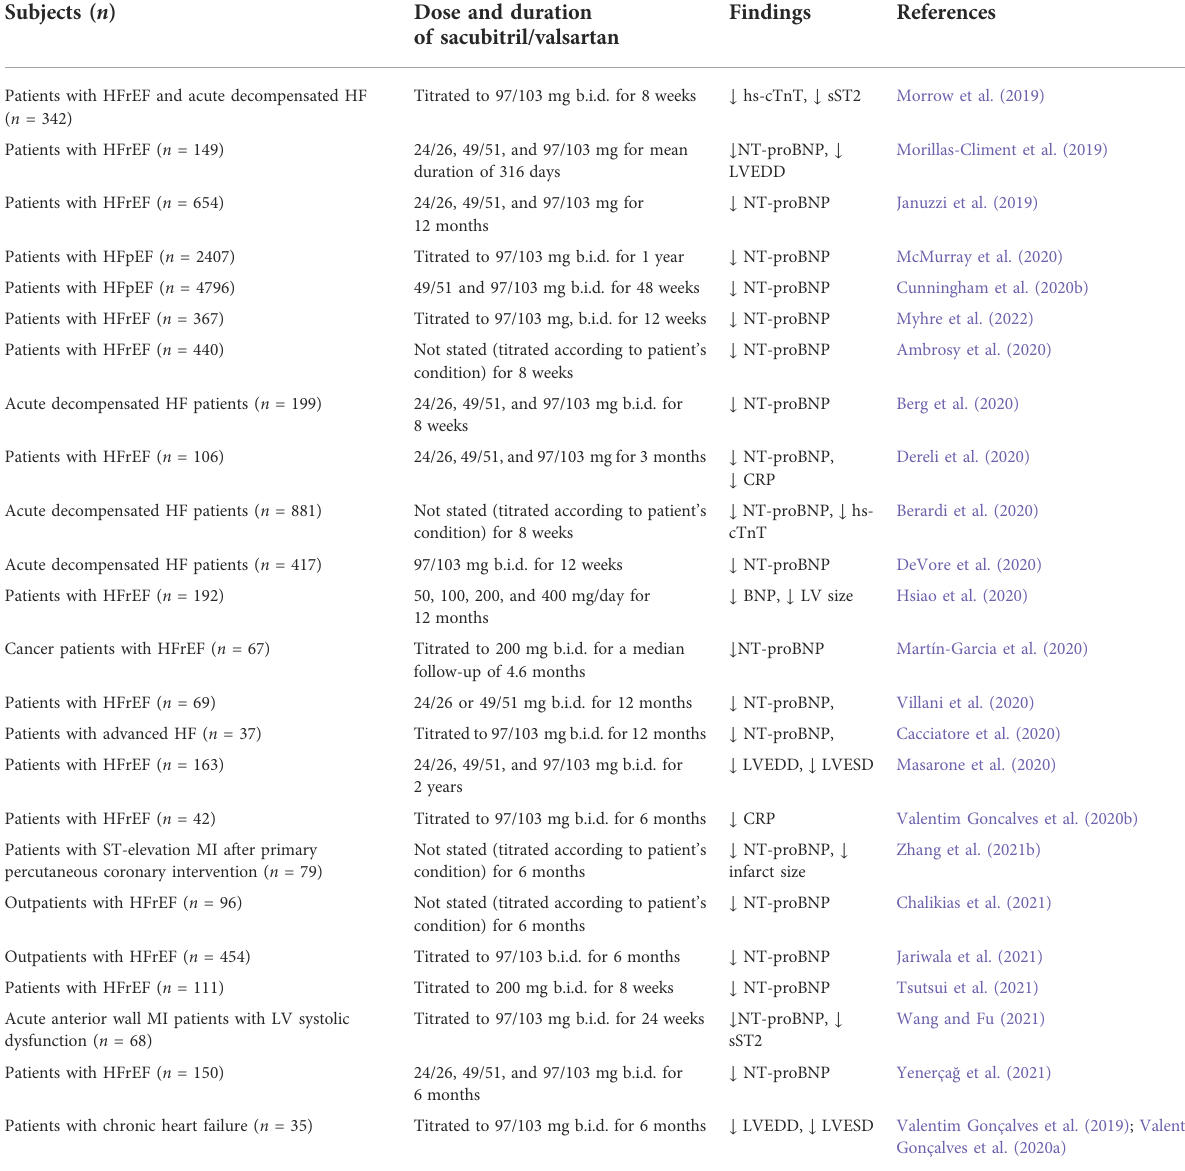
TABLE 3 The effects of sacubitril/valsartan on cardiac structure and biomarkers of cardiac hypertrophy in clinical studies. Subjects ( n